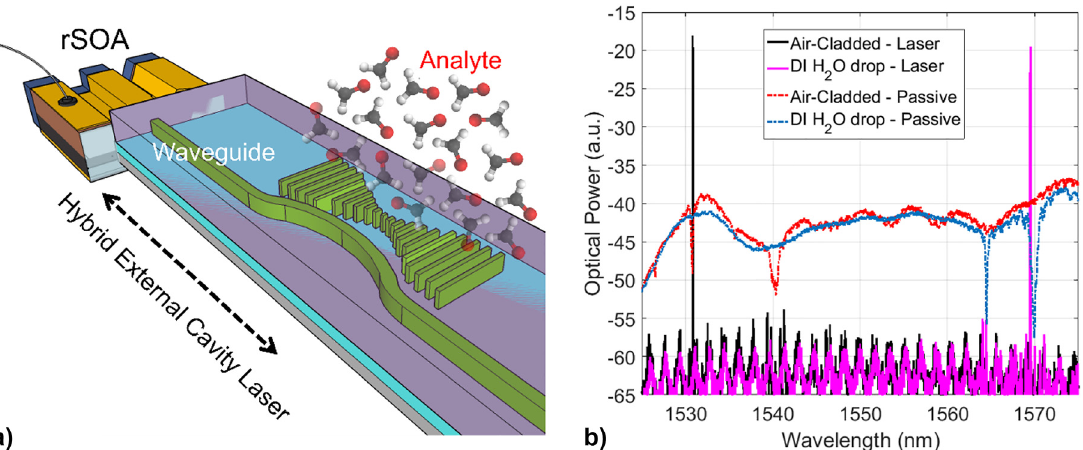
Figure 10: HECL sensor, (a) Schematics of a hybrid external cavity laser (HECL) based on the designed 1D PhC cavity, operating as biosensor and (b) same HECL device lasing with different upper-cladding solutions, in which the lasing wavelength with different solutions is overlapped to the transmission dip of the 1D PhC cavity taken in the same cladding conditions (air in black and de-ionised water in magenta). The lasing wavelength shifts with the shifting of the PhC cavity resonance, as the solution covering the microcavity changes (from air to de-ionised water)